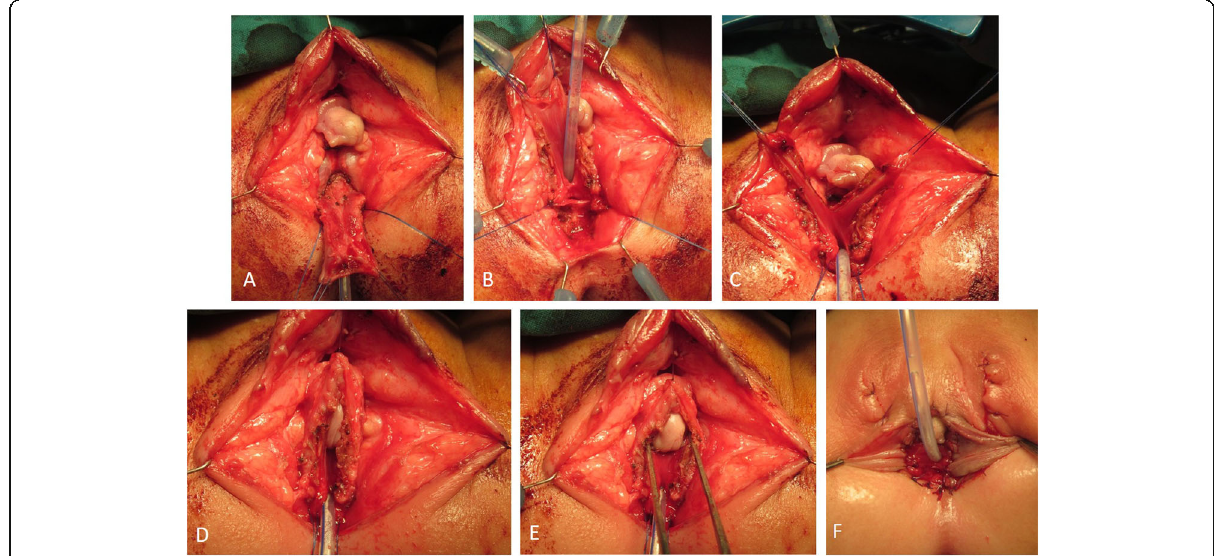
Fig. 9 Feminizing genitoplasty in a 15-month-old girl with CAH. Fixation of the urethra to the clitoris. Note the divergence of the ventral erectile tissue on the dorsum of the common urogenital sinus in a denoting a low vaginal descent (type 1). The vaginal orifice was easily exposed via a lay-open incision through the dissected urogenital sinus in b . The distal urogenital sinus is used to cover the retained glans ( c – e ) and provide a mucosal lining to the new vestibule. f Appearance of external genitalia at the end of